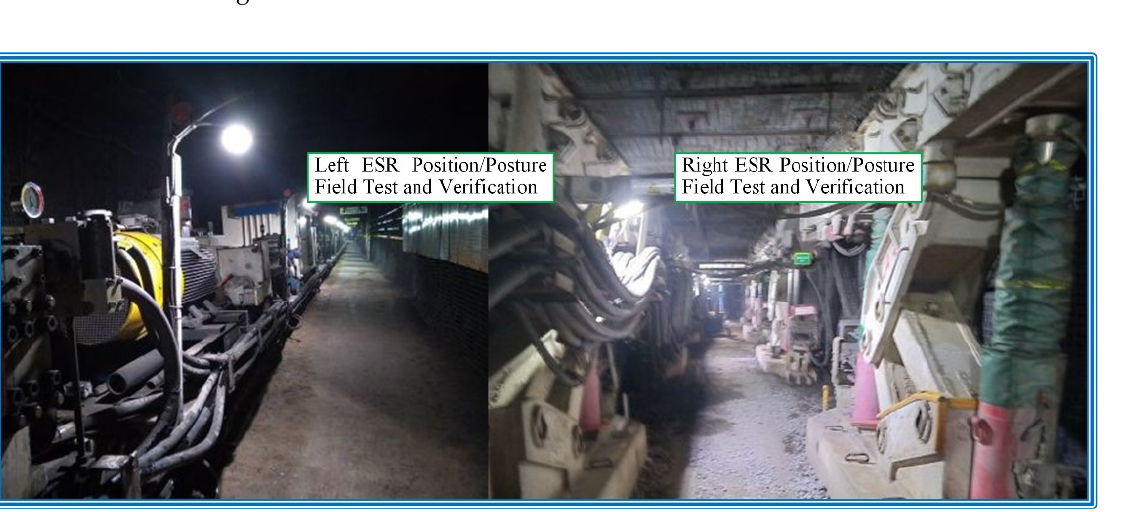
Figure 15. ESR field testing and actual verification.